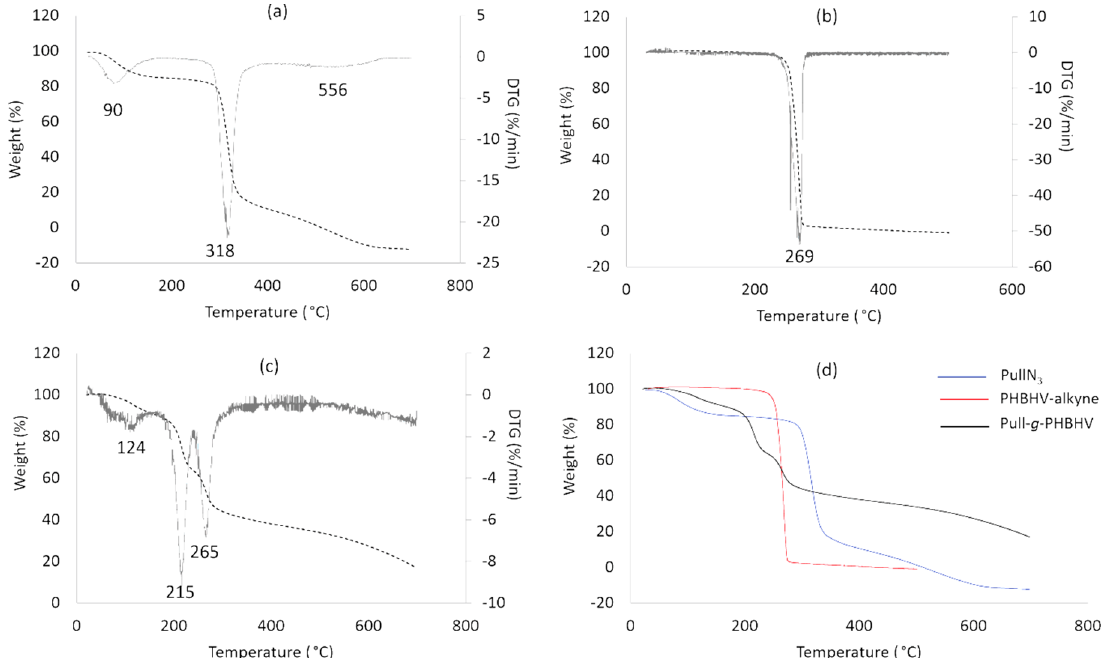
Figure 7. Thermogravimetric curves of PullN 3 ( a ), PHBHV-alkyne ( b ) and Pull- g -PHBHV ( c ), with the respective derivatives, as well as correlation between the thermogravimetric curves of the functionalized polymers and the grafting product ( d ).